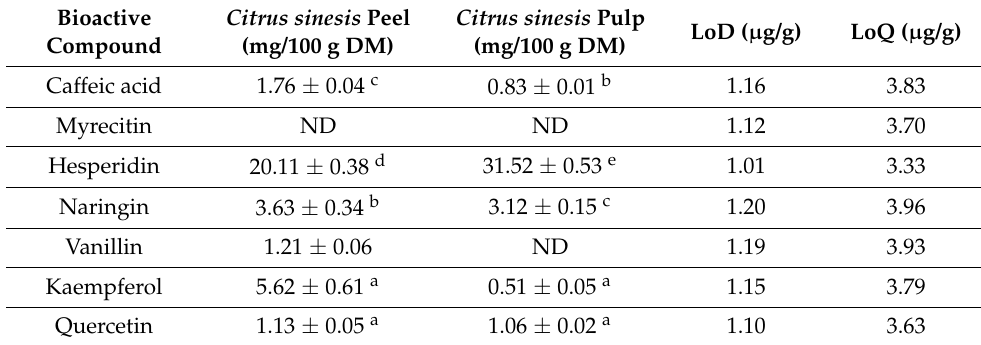
Table 5. Bioactive compounds analyzed using